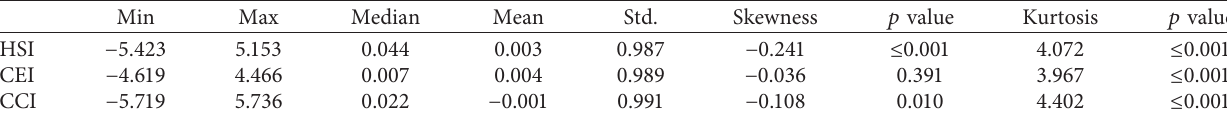
Figure 6: Standard deviation series of NAGARCH model. (a) HSI. (b) CEI. (c) CCI. Table 4: Univariate descriptive statistics of standardized residuals.